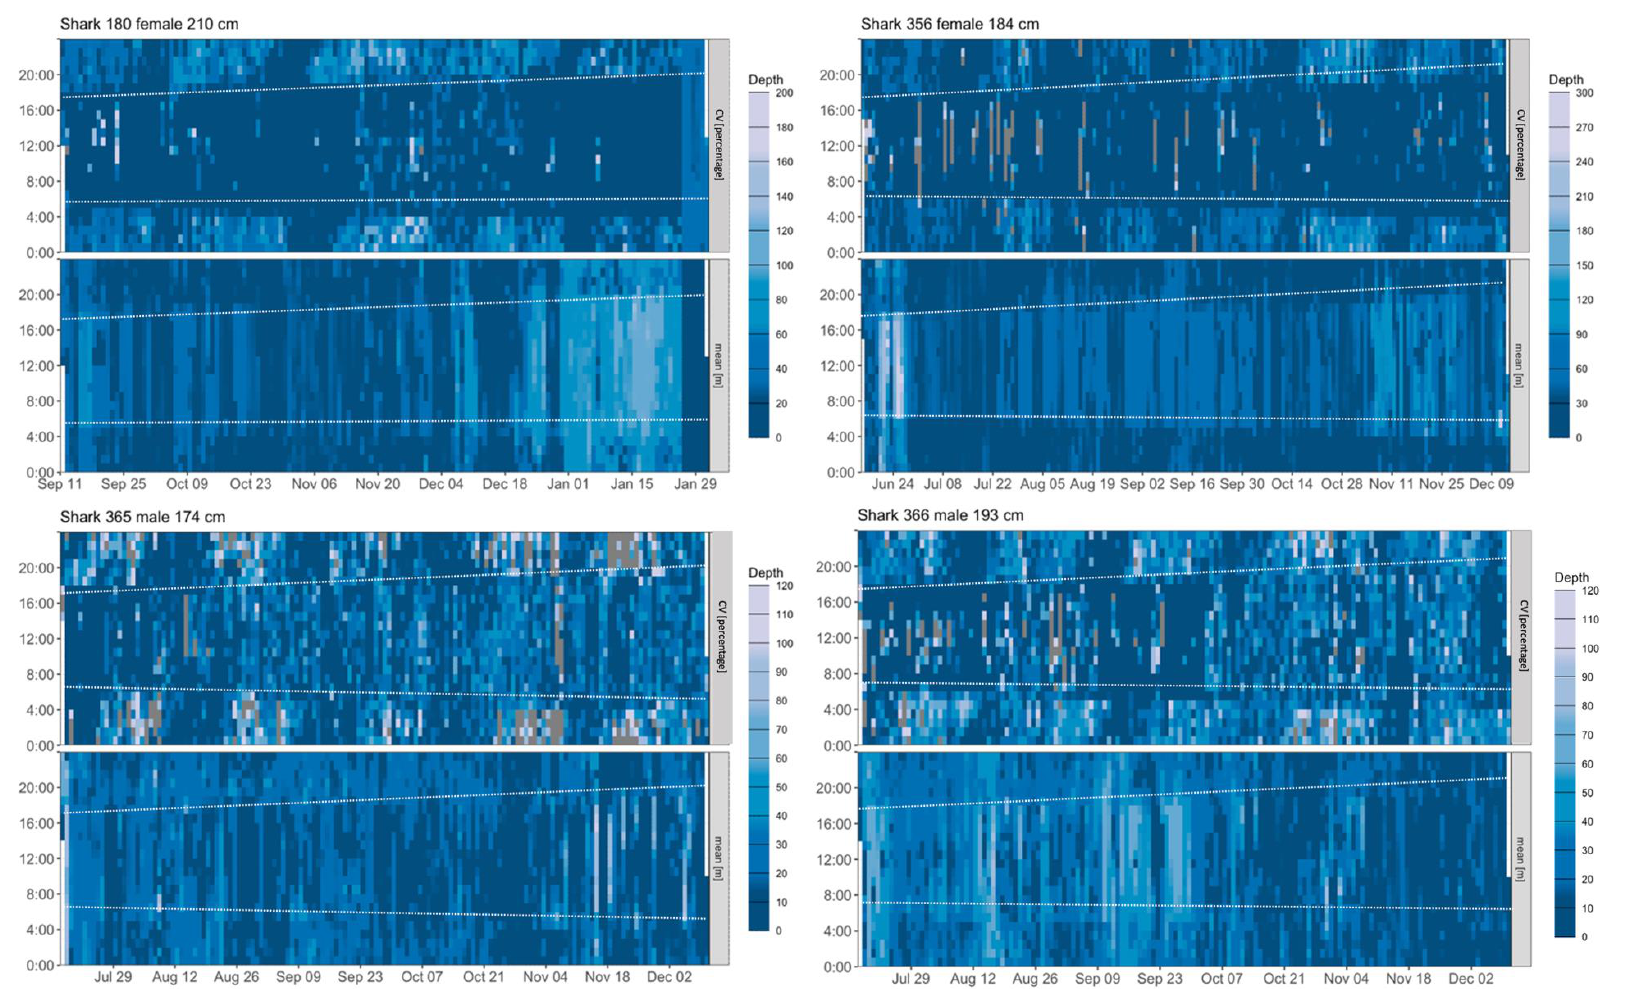
Figure 3. Vertical activity analysis based on recovered tag data. Coefficient of variation values and associated mean depth occupation for each of the four datasets displayed over 24 h for the entire tracking period for sharks 180, 356 and 365, 366. The same colour/numeric scale is shared by mean depth (in meters) and coefficient of variation in depth (expressed as a percentage). Dotted lines indicate times of local sunrise and sunset.